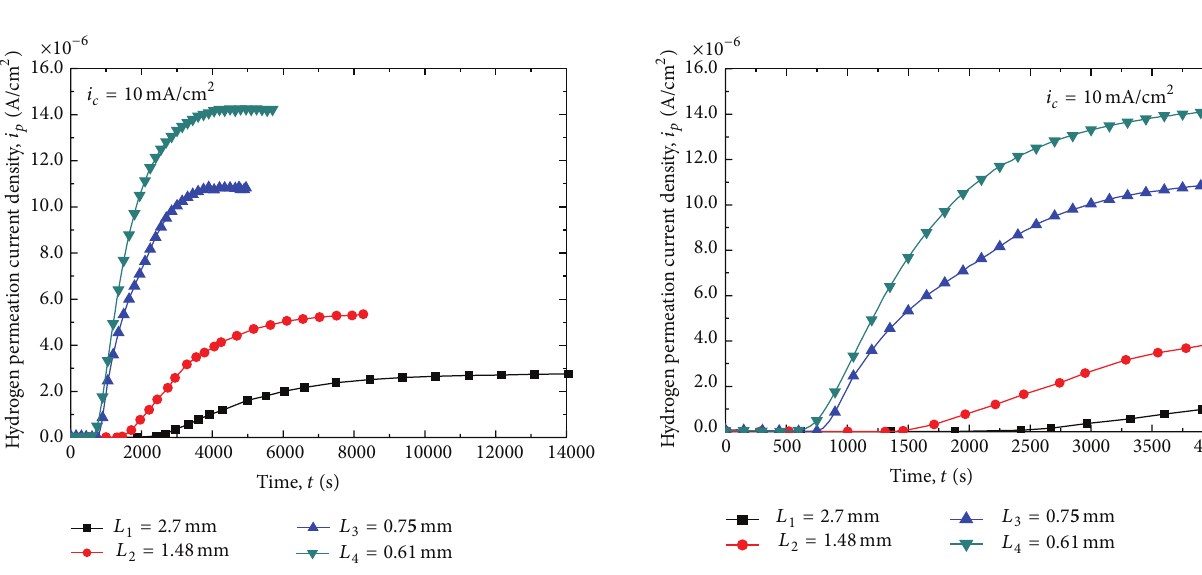
Figure 6: Hydrogen permeation curves fordifferent thickness of the silicon steel at initial charging